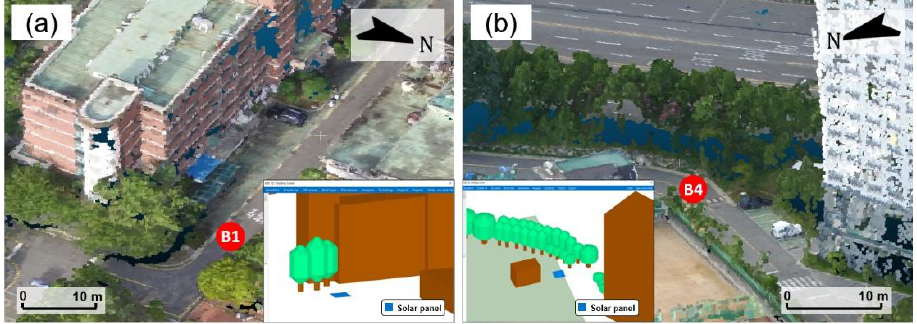
Figure 17. 3D point clouds and 3D tree models at survey points ( a ) B1 and ( b ) B4.